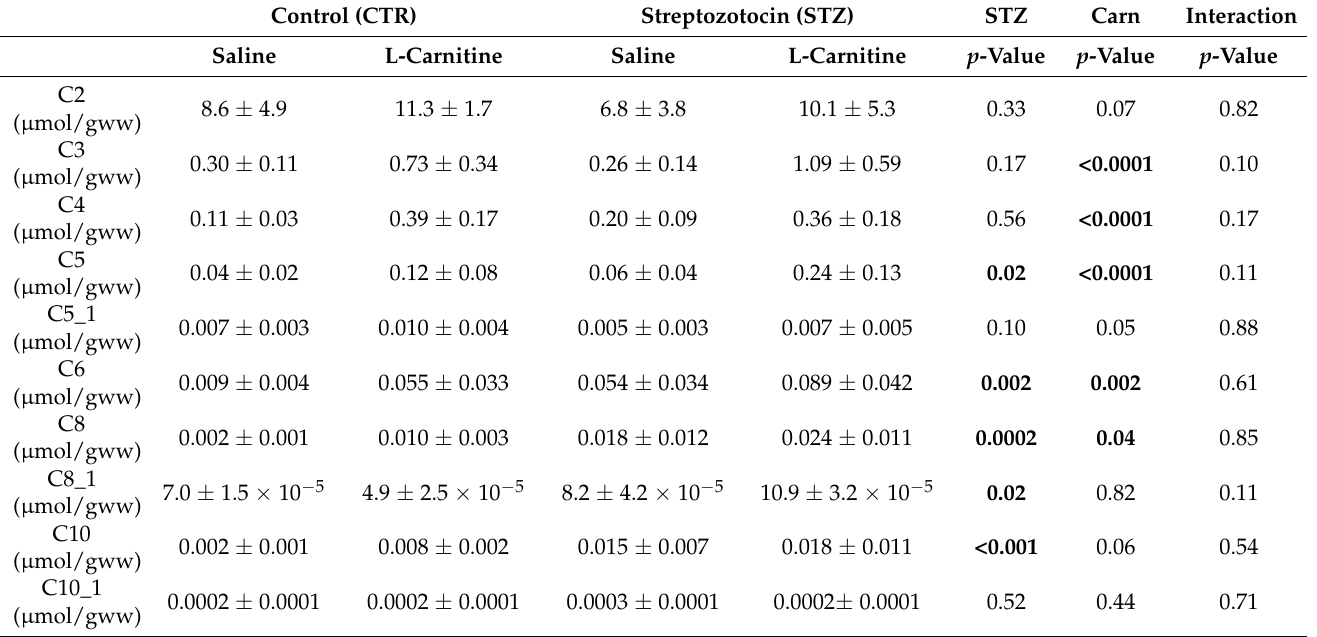
Table 2. Short-chain cardiac acyl-carnitine levels for the different species assessed. Data are presented as mean ± SD. Two- way ANOVA. p -value displayed with the effect of streptozotocin (STZ), the effect of L-carnitine (Carn) and the interaction between the two